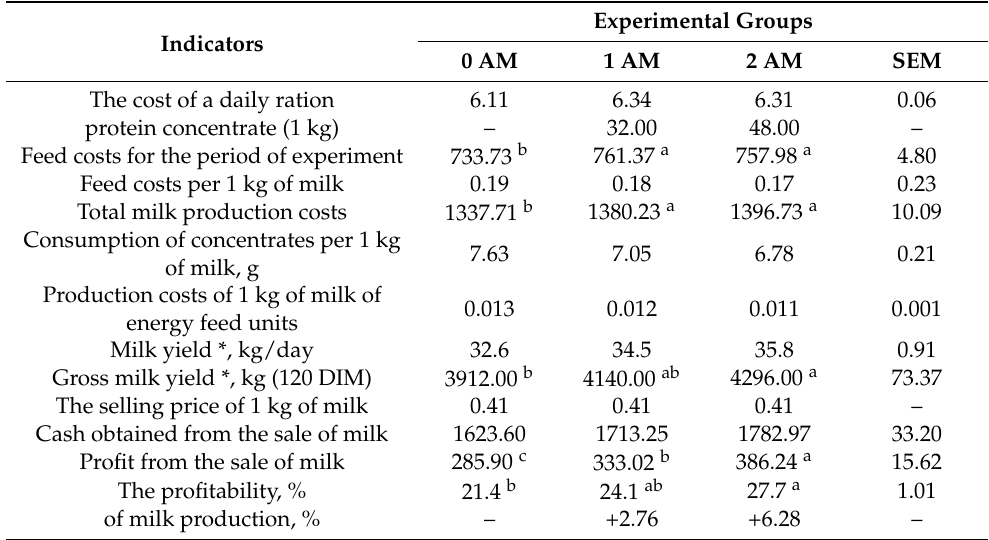
Table 9. The economic value of inclusion of Agro-Matic protein concentrate when feeding Ayrshire dairy cows during the early lactation period